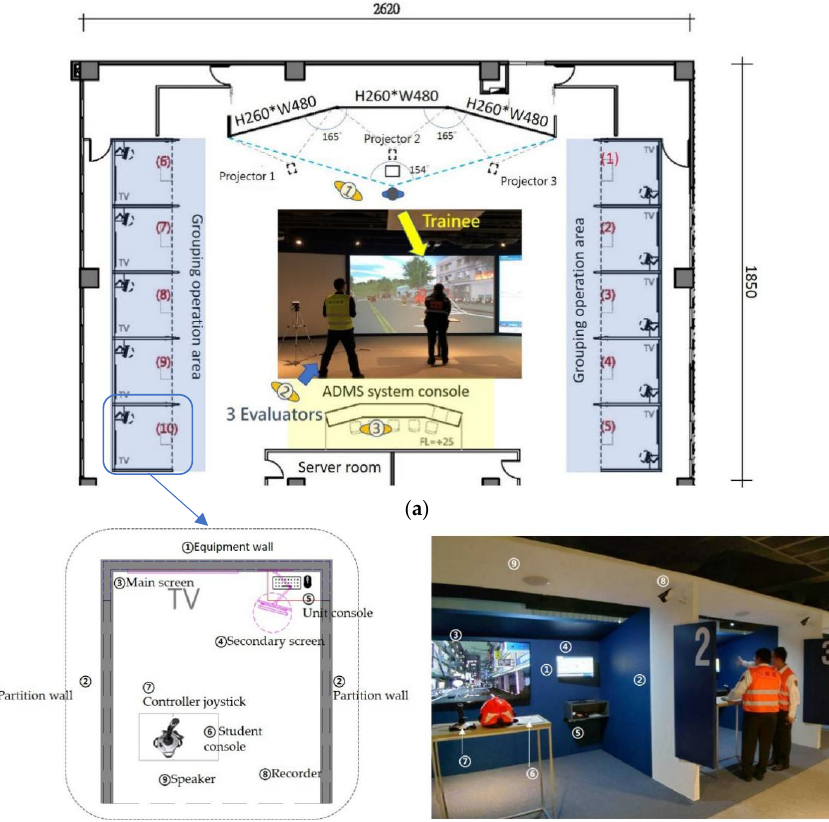
Figure 5. ( a ) The plan configuration diagram of the on-site simulation training field. ( b ) Equipment configuration diagram of the individual operation area. (The numbers in the sub-figures correspond to the text descriptions in the left figure.).